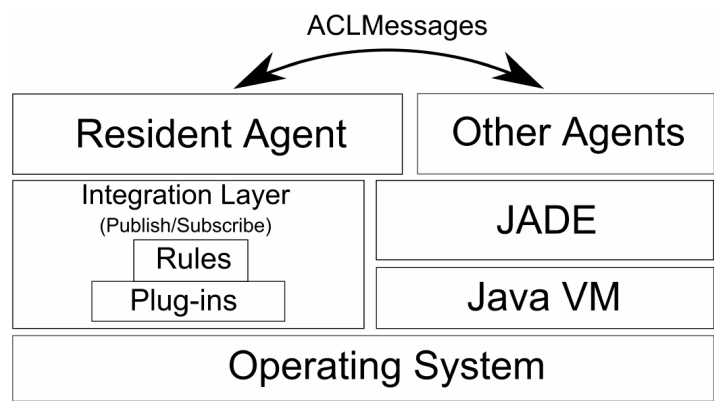
Figure 6. Resident and other JADE agents in the software